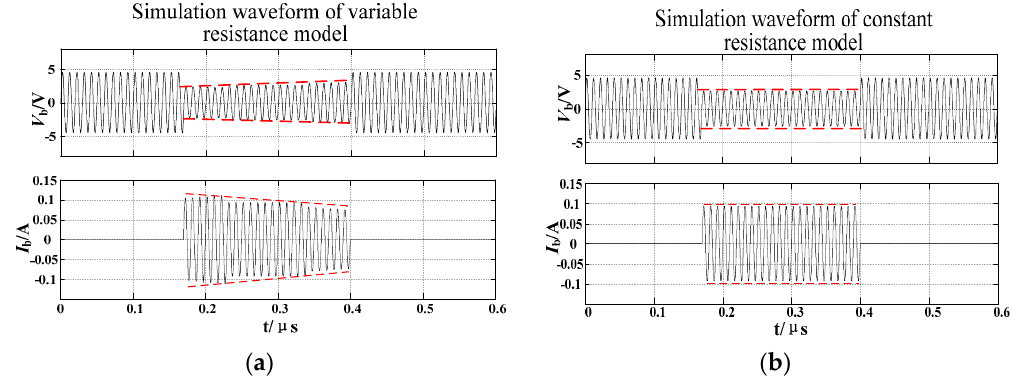
Figure 10. Simulation waveforms of ( a ) the variable resistance models and ( b ) the constant resistance models.